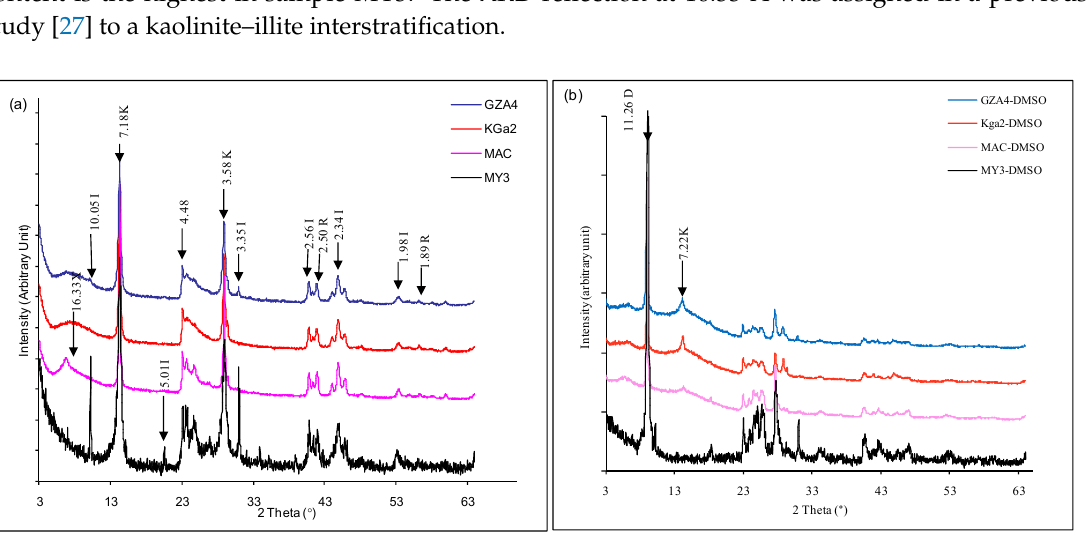
Figure 2. XRD patterns of ( a ) the raw and ( b ) the DMSO–intercalated kaolinite samples.